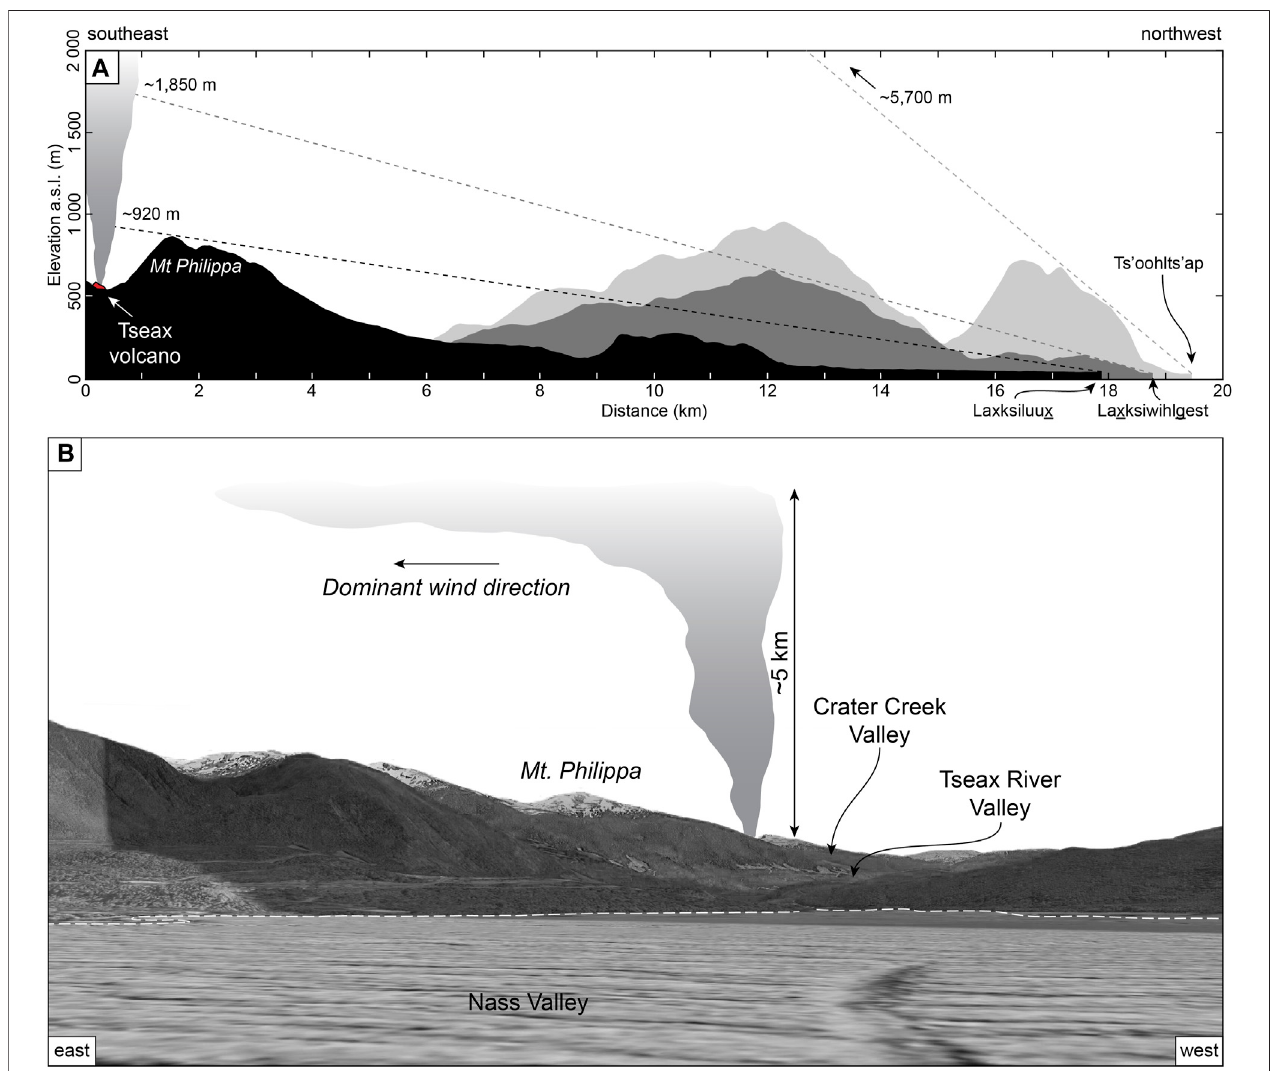
FIGURE 9 | (A) Minimum height estimate of the convective plume using lines of sight of a person standing in the former Nisga ’ a villages towards the location of Tseax volcano. (B) An ~5 km high buoyant plume seen from the former location of Laxksiluux.